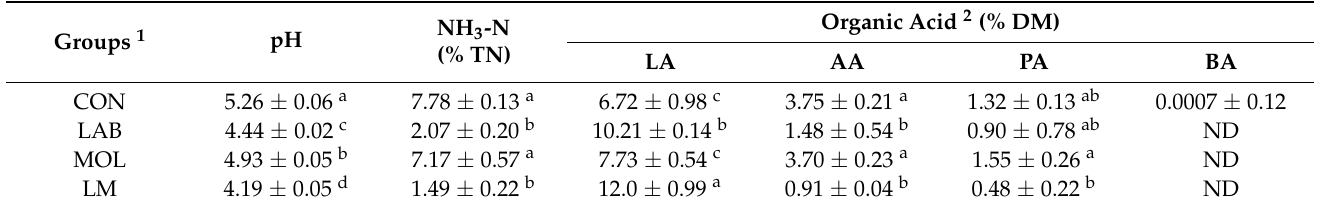
Table 2. Effects of different additives on the fermentation profile of paper mulberry silage.